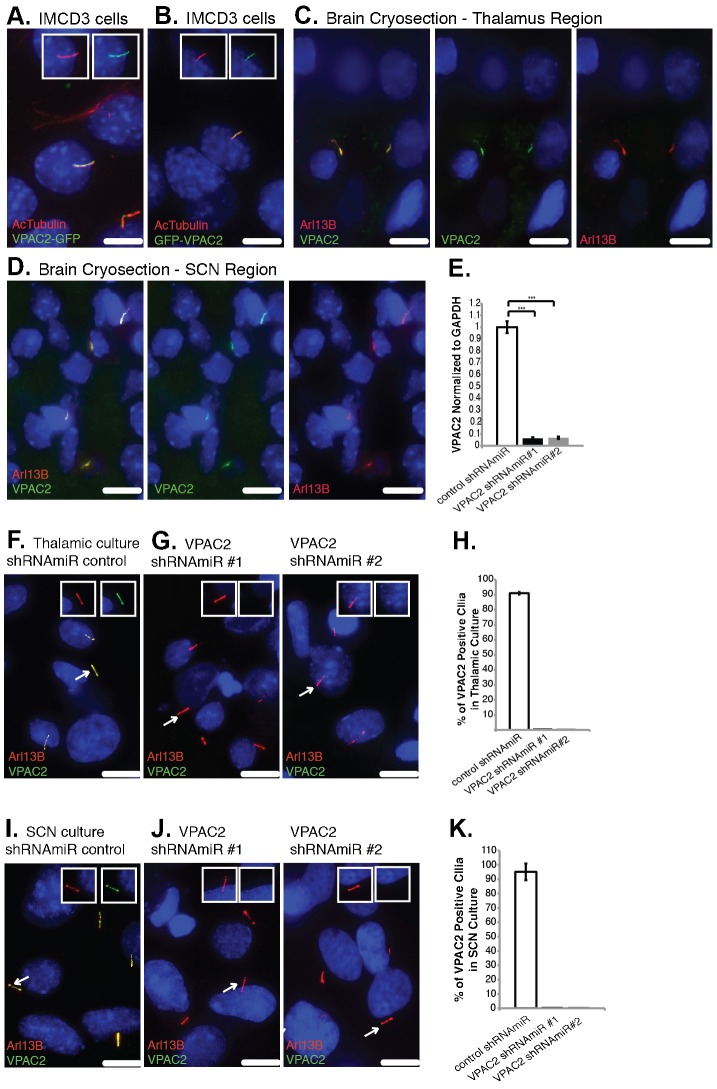
Endogenous VPAC2 localizes to primary cilia.(A,B) VPAC2-GFP and GFP-VPAC2 target to IMCD3 primary cilia. IMCD3 cells expressing VPAC2-GFP (A) or GFP-VPAC2 (B) were serum starved to induce ciliogenesis and immunostained for acetylated α-tubulin (AcTubulin, red). (C,D) Endogenous VPAC2 localizes to primary cilia in the thalamus and SCN regions of the rat brain. Rat thalamus (C) and SCN (D) cryosections were fixed and immunostained for VPAC2 (green) and Arl13B (red). Seventeen sections at 0.2 µm intervals were projected using sum over z-axis. (E) VPAC2 mRNA levels were reduced by ∼94% in thalamic cultures infected with lentivirus containing VPAC2 shRNAmiR #1 or VPAC2 shRNAmiR #2 compared to cells infected with control lentivirus. mRNA levels were measured by RT-qPCR. Error bars represent the standard deviation (SD) of triplicate PCR assays. ***P<0.001. GAPDH levels were used as an internal control for normalization. (F,G) VPAC2 localizes to primary cilia in thalamic neuron culture. Thalamic neuron culture was infected with lentivirus containing control shRNAmiR (F) or shRNAmiRs against VPAC2 (G) and immunostained for VPAC2 (green) and Arl13B (red). (H) Thalamic neuron culture cells were prepared and stained as in (F,G). Approximately 450 cilia were counted and the percentage of VPAC2 positive cilia was plotted. Error bars represent the SD among three different coverslips. (I,J) VPAC2 localizes to primary cilia in SCN neuron culture. SCN neuron culture was infected with lentivirus containing control shRNAmiR (I) or shRNAmiRs against VPAC2 (J) and immunostained for VPAC2 (green) and Arl13B (red). (K) SCN neuron culture cells were prepared and stained as in (I,J). Approximately 200 cilia were counted and the percentage of VPAC2 positive cilia was plotted. Error bars represent the SD among microscopic fields. (A–D,F,G,I,J) DNA was labeled with DAPI. Insets show unmerged images of the region around a cilium. Scale bars: 5 µm.